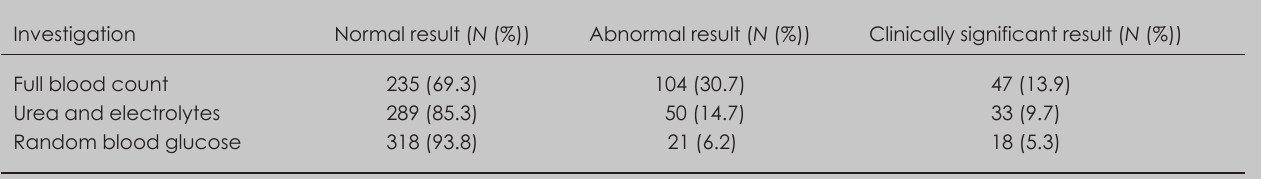
Table II. Frequency of normal, abnormal and clinically significant laboratory